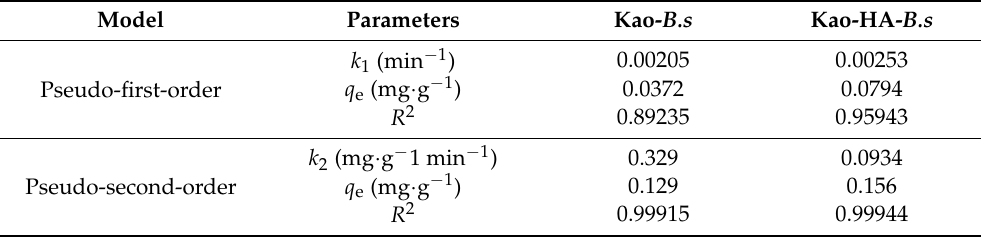
Figure 4. The adsorption kinetics of As(V) on Kao- B.s and Kao-HA- B.s (50:1:50) (C 0 : 1.0 mg · L − 1 ; adsorbent dosage: 2.5 mg · L − 1 ; T: 25 ◦ C; ionic strength: 0.01 mol · L − 1 ; pH: 5). Table 1. Adsorption kinetics parameters for As(V) on Kao- B.s and Kao-HA- B.s